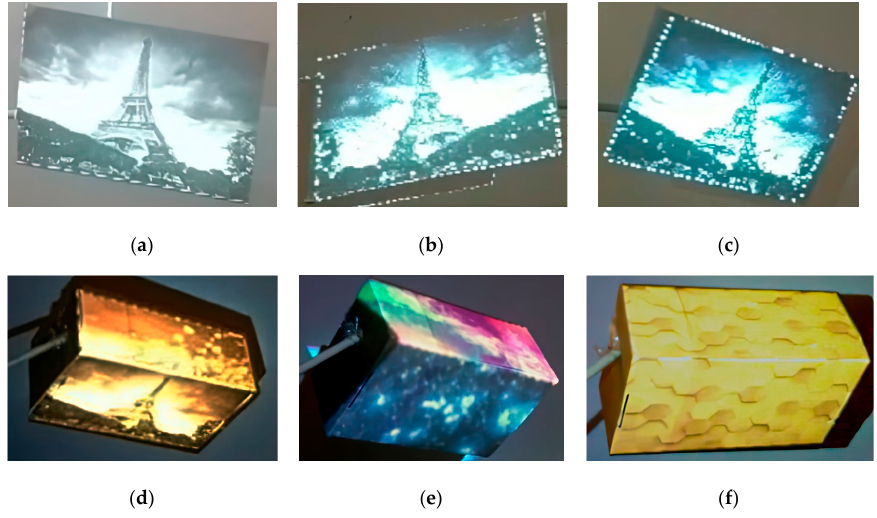
Figure 9. Pictures showing projections on a moving sheet of A4 paper ( a – c ) and a box ( d – f ).